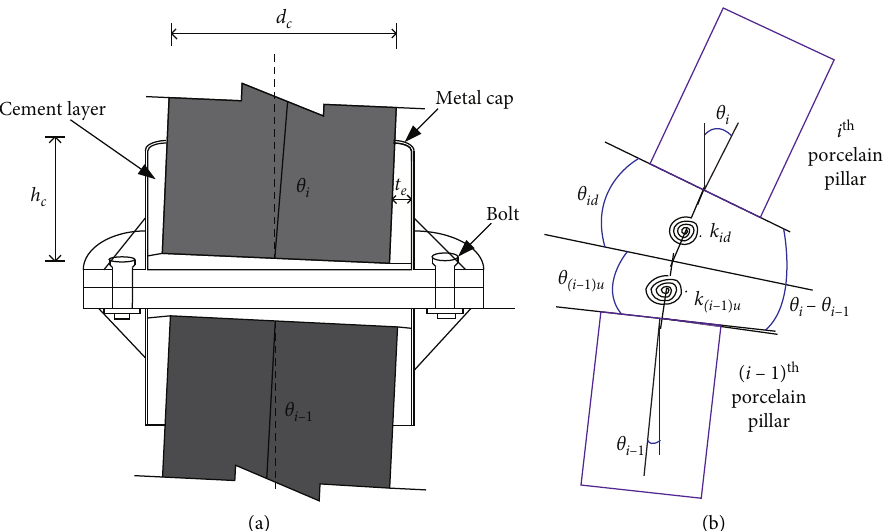
Figure 3: Analysis diagram of flange connections. (a) Deformation diagram of the cemented joint. (b) Mechanical model of flange connection.